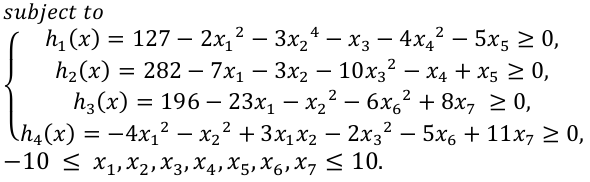
Figure 8. Convergence curve and 30 best solutions for constraint problem